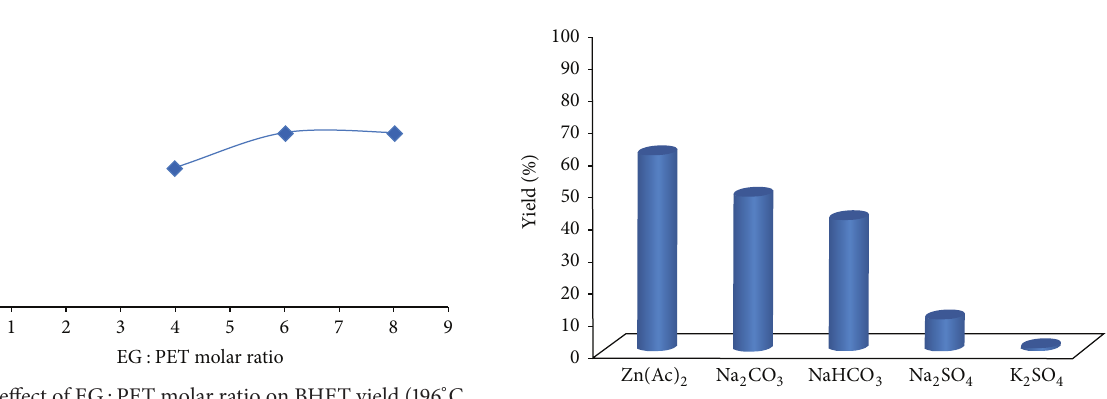
Figure 9: The effect of zinc acetate compared to others (BHET) yields in the glycolysis of clear PET catalyzed by several metal salts (196 ∘ C, EG :PET molar ratio 7.6:1, PET:catalyst molar ratio 380:1) [8].